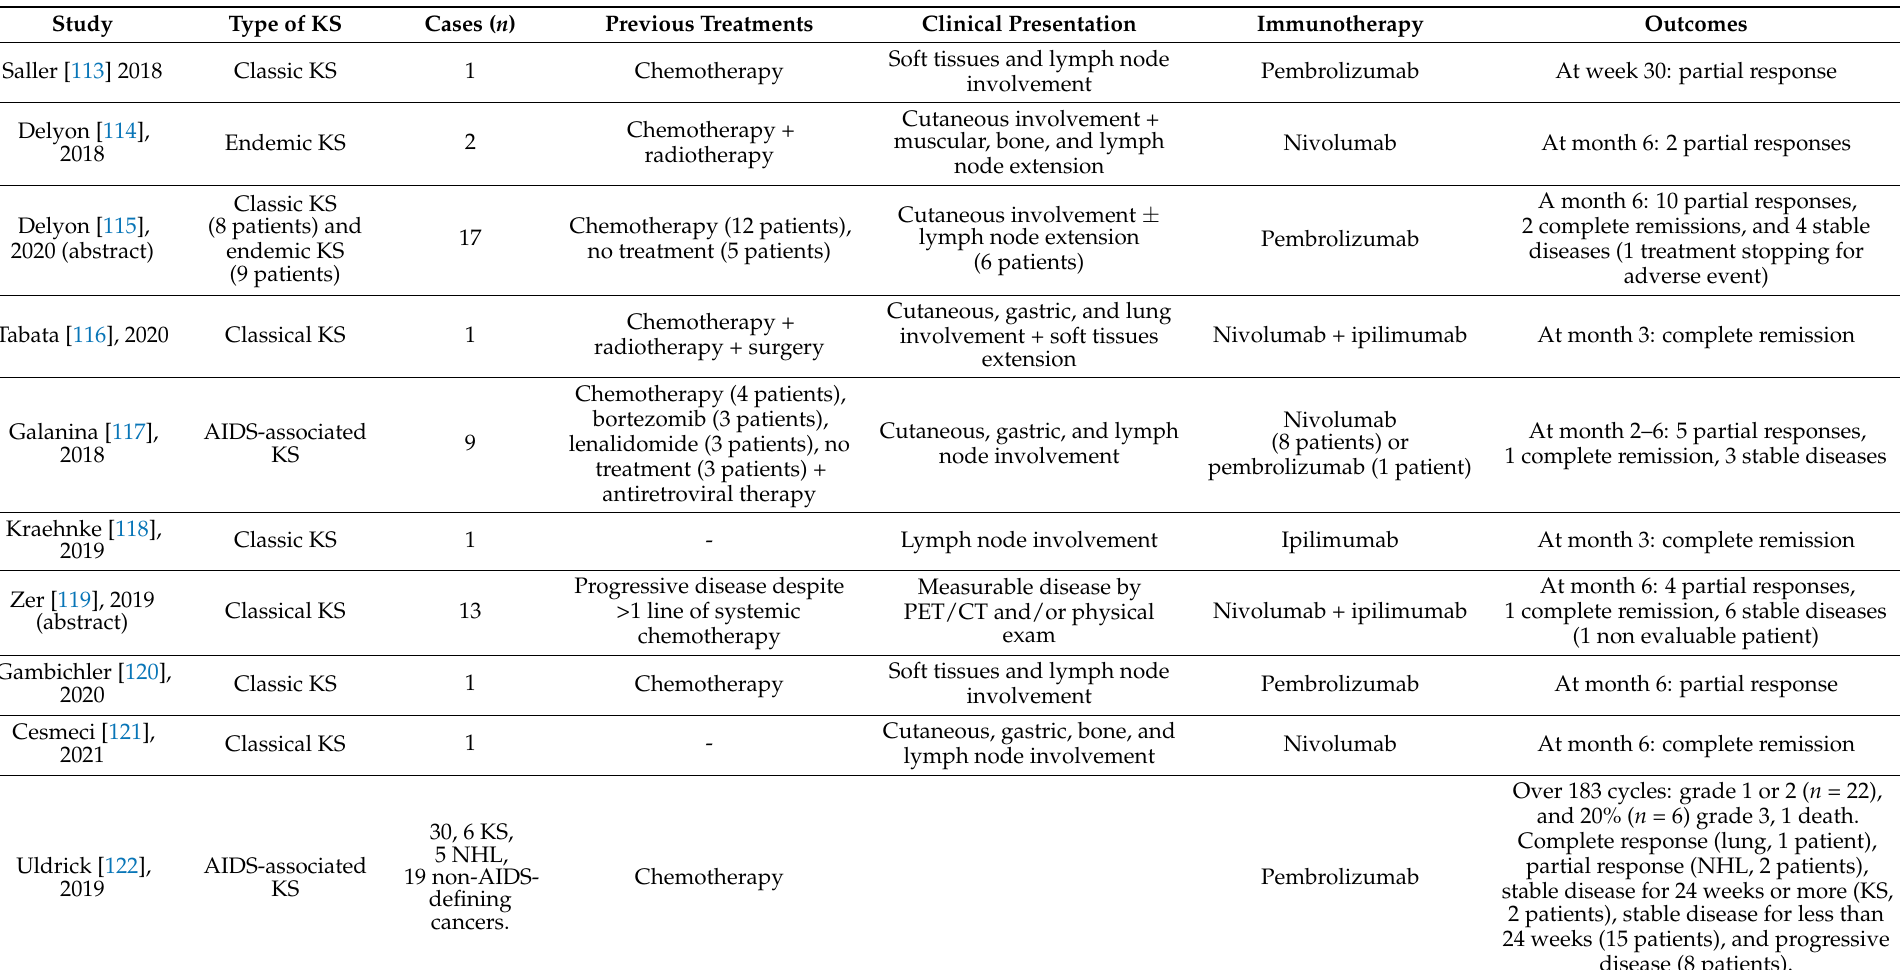
Table 2. Clinical cases and series evaluating immune checkpoints inhibitors in classic and AIDS-associated